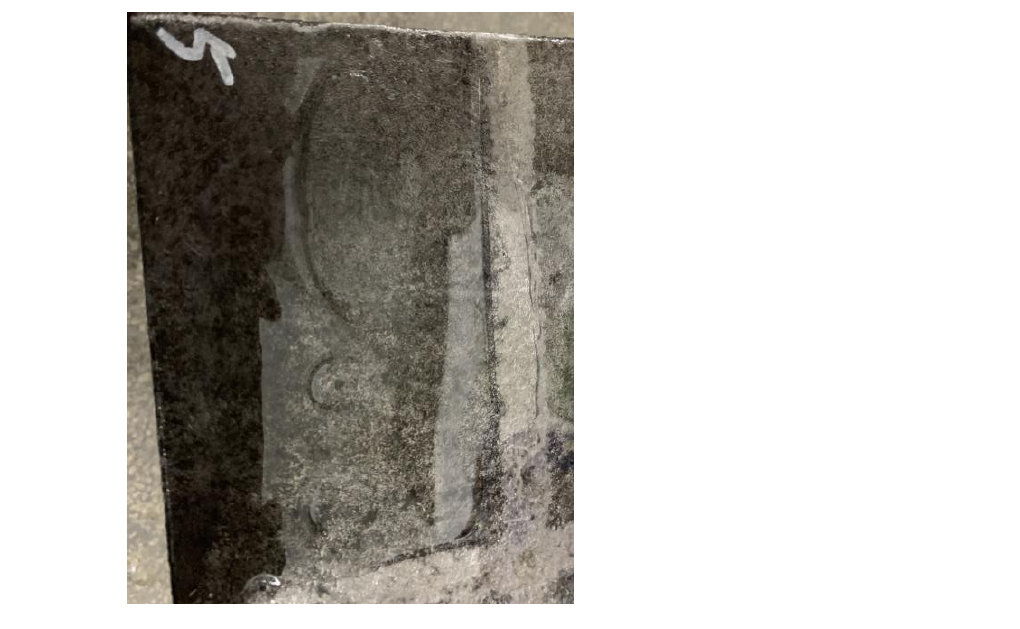
Figure 6. Combination 5 shows shrinkage of the adhesive layer oil after coating, with the steel plate exposed.